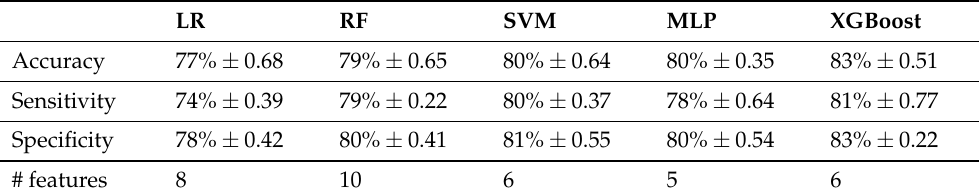
Table 4. Quantitative evaluation of the second stage of our system when filter-based method is the feature selection scheme. The values are average accuracy ± standard deviation.